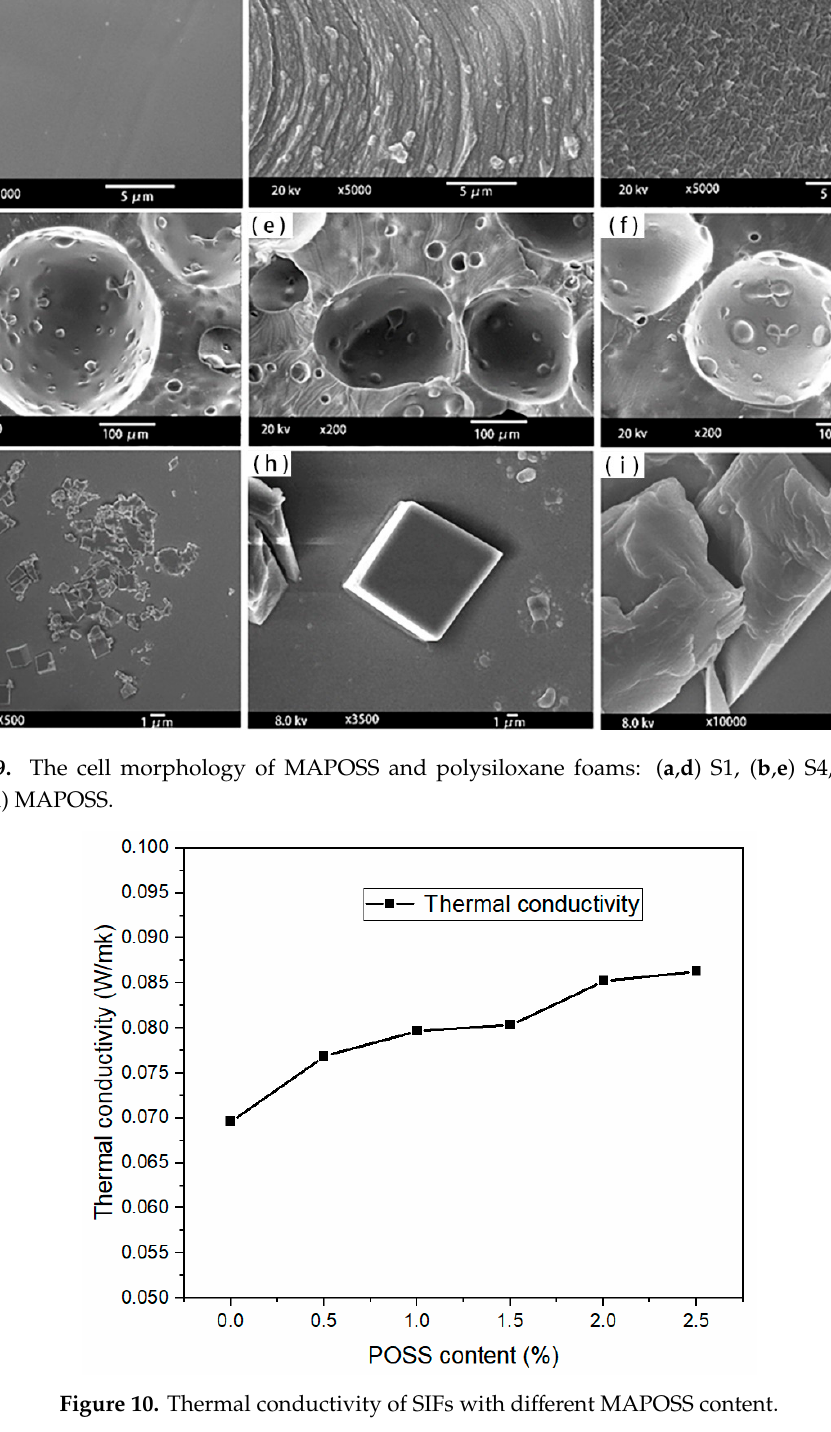
Figure 9. The cell morphology of MAPOSS and polysiloxane foams: ( a , d ) S1, ( b , e ) S4, ( c , f ) S6, and ( g – i ) MAPOSS.